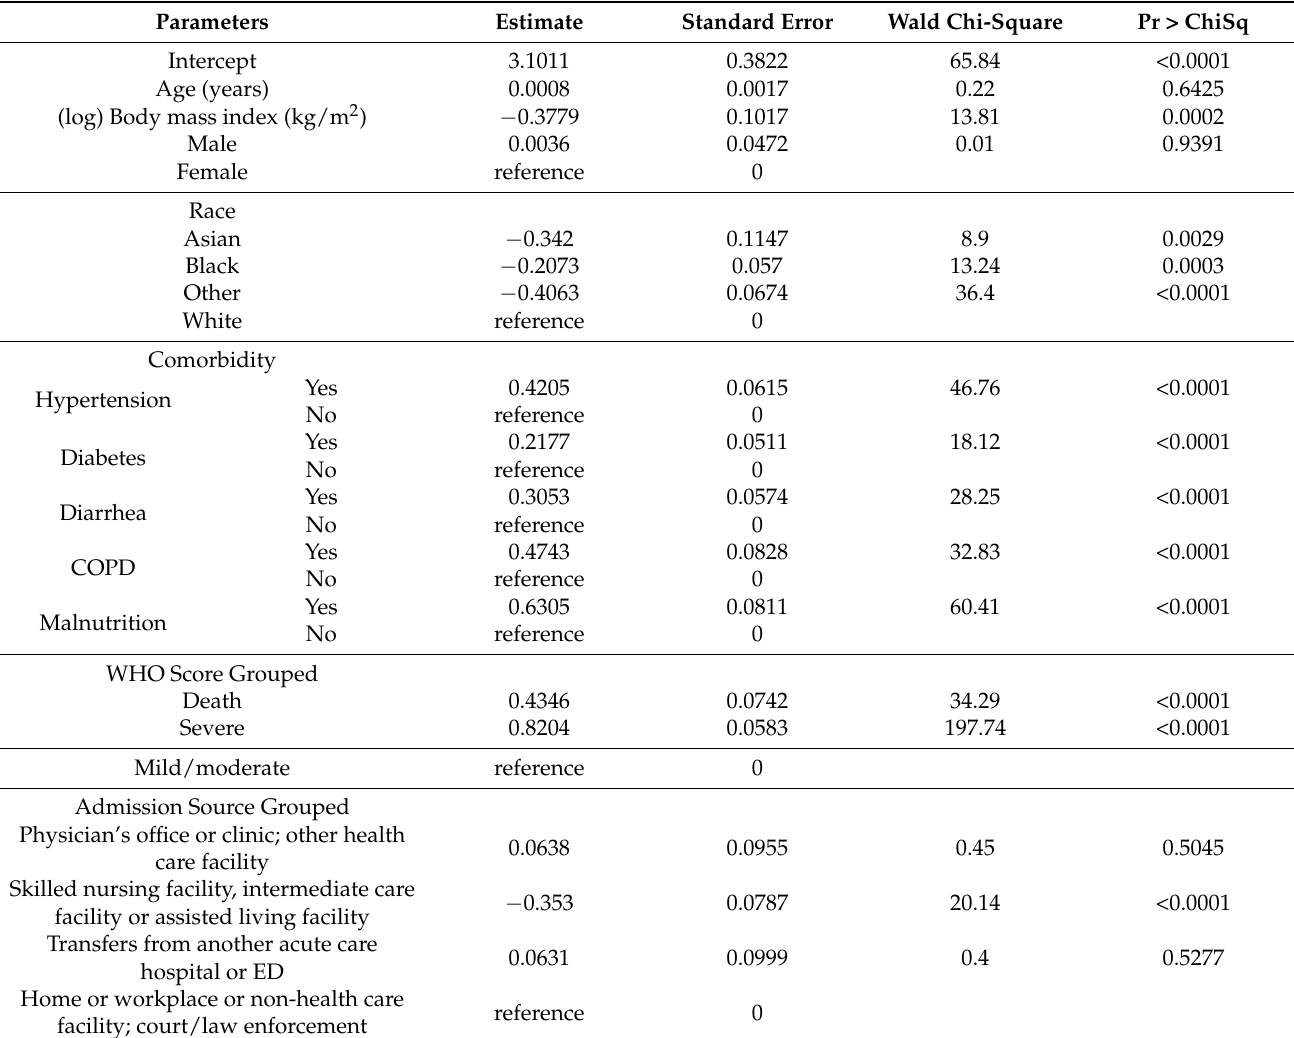
Table 5. Multivariable linear regression predicting the (log) hospital length of stay, ICU patients only (n =